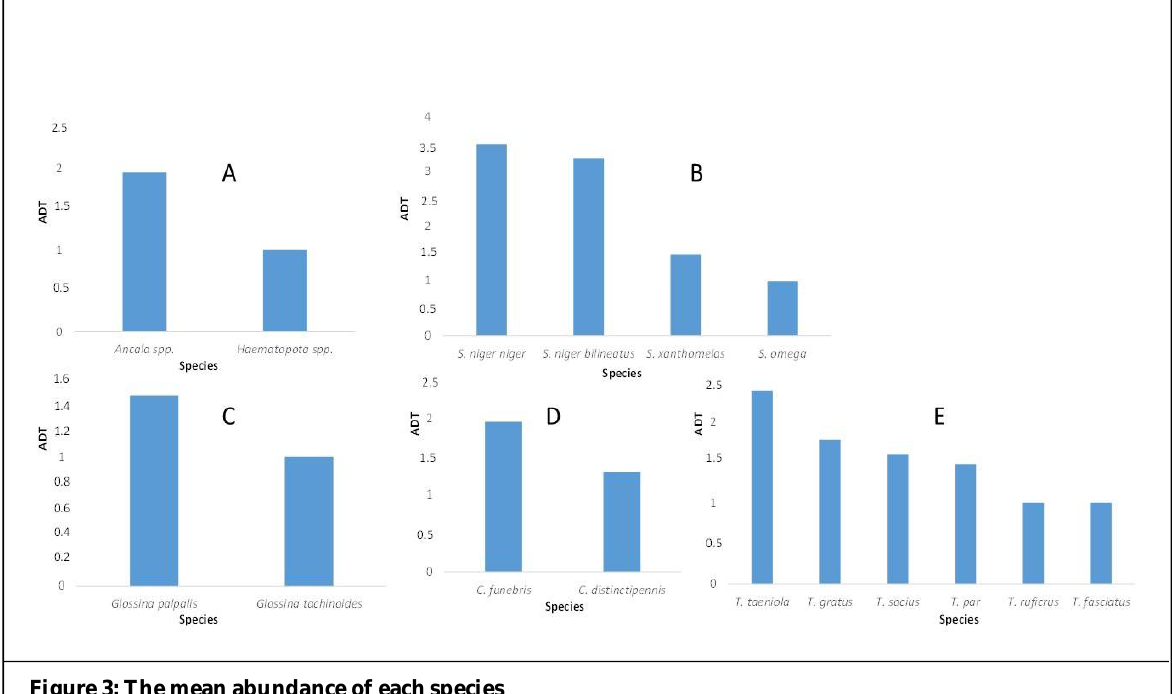
Figure 3: The mean abundance of each species